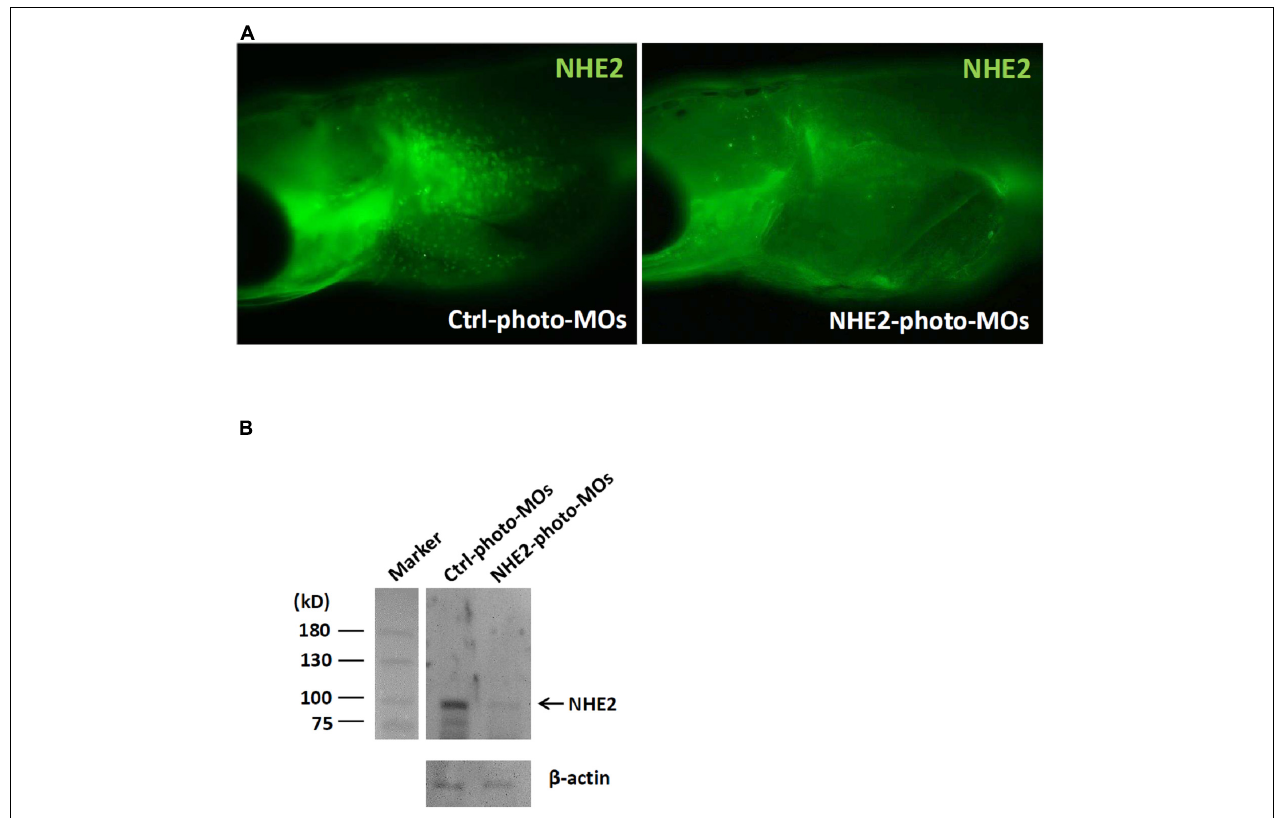
FIGURE 7 | Na + /H + exchanger 2 (NHE2) protein expression in seawater (SW)-acclimated medaka embryos. (A) Immunocytochemistry of NHE2 in 8-day post-fertilization (dpf) medaka embryos in the control (Ctrl) photoactivated morpholino oligonucleotide (photo-MO) and NHE2 photo-MO groups. (B) Western blot analysis of NHE2 in the Ctrl photo-MO and NHE2 photo-MO groups. β -Actin was used as an internal